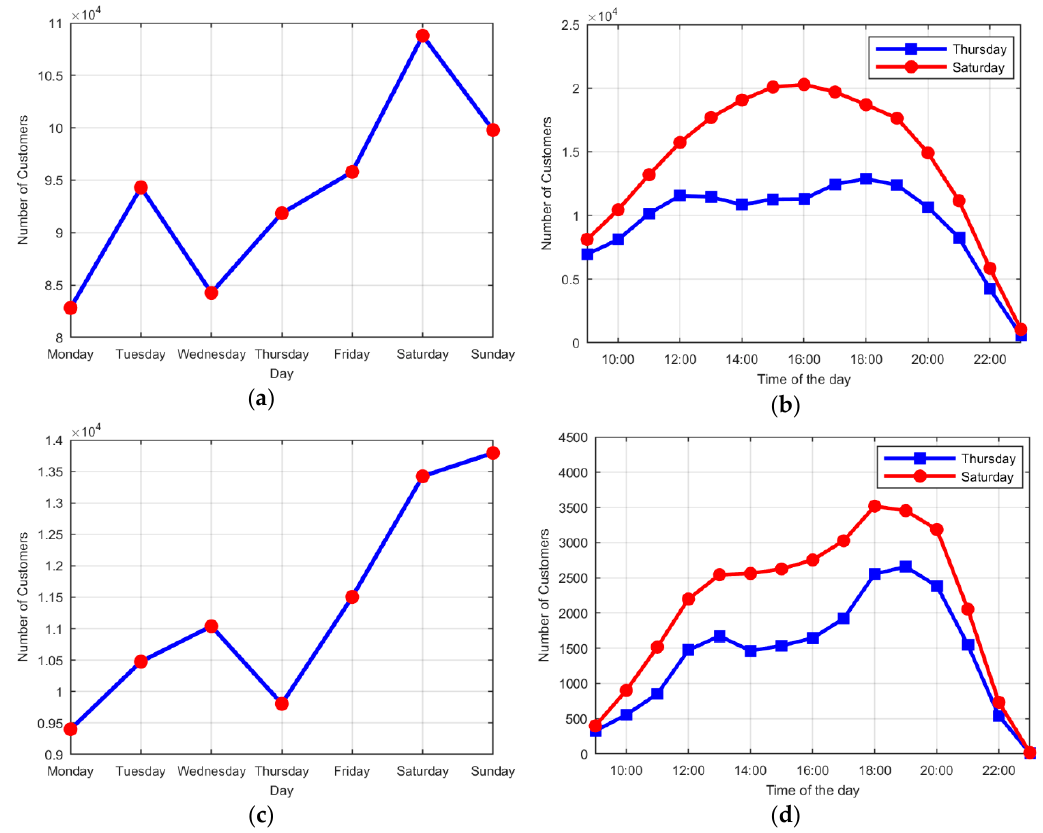
Figure 5. Weekly and hourly customer flows of the two shopping malls. ( a , b ) DYC; ( c , d )